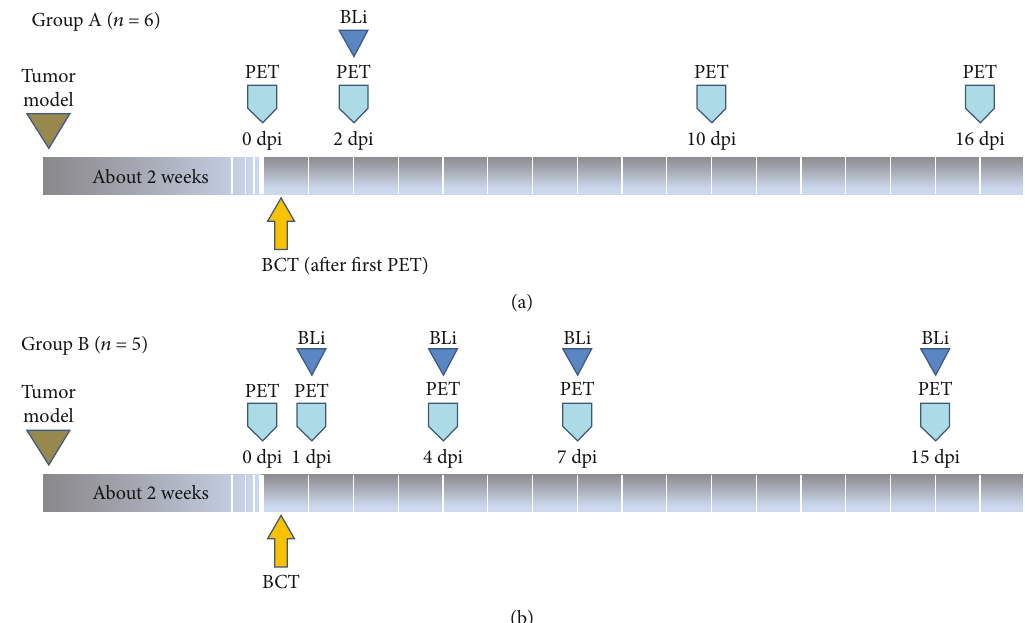
Figure 1: Study overview. This pilot study was performed using two separate trials: A and B. A tumor was generated in the right thigh of each mouse (BALB/c female mice, 6-weeks-old) using the murine CT26 colon adenocarcinoma cells. After tumor volume reached approximately 180 mm 3 , BCT was performed by intravenous injection of bacterial cells via the tail vein ( bacterialdose = 4 : 5 × 10 7 CFU/ mouse in 100 μ L PBS). Two trials were designed to avoid animal preparation issues such as fasting and general anesthesia. In trial A ( n = 6 ), FDG PET/CT images were acquired at 0 dpi, 2 dpi, 10 dpi, and 16 dpi (a). In trial B ( n = 5 ), FDG PET/CT images were acquired at 0 dpi, 1 dpi, 4 dpi, 7 dpi, and 15 dpi (b). In vivo BLi con fi rming the presence of tumor-targeting bacteria was performed at 2 dpi, immediately after PET/CT in trial A, and immediately after each PET/CT in trial B. Abbreviations: FDG, 2-deoxy-2[ 18 F] fl uoro-D- glucose; dpi, days post-injection; SUVmax, maximum standardized uptake value; SUVmean, mean standardized uptake value; PBS, phosphate-bu ff ered saline; CFU, colony-forming units; BLi, bioluminescence